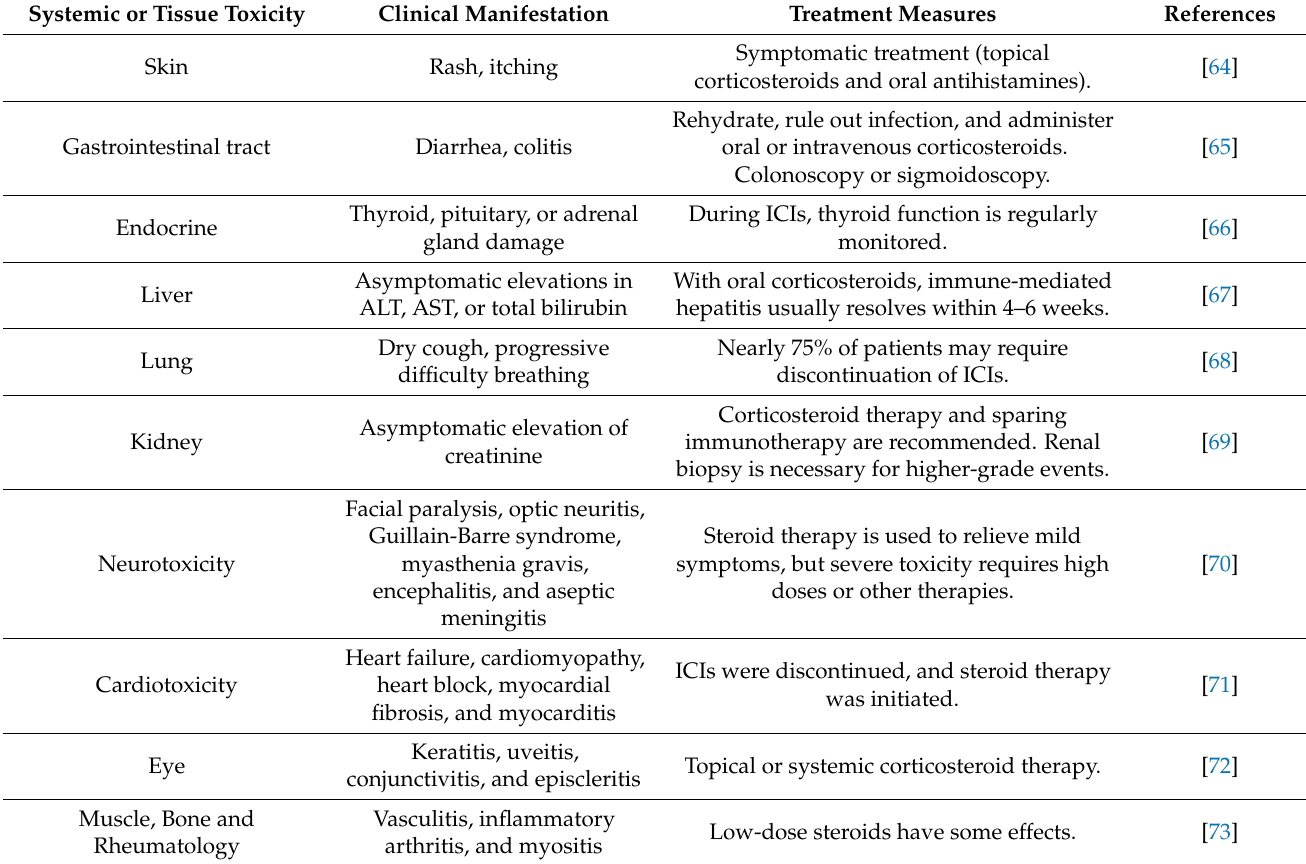
Table 2. Common immune-related adverse